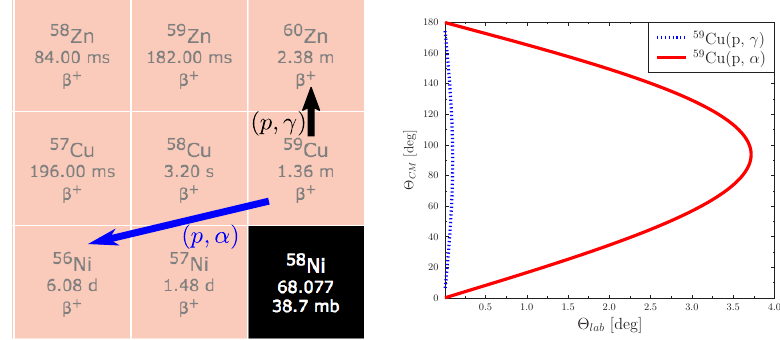
Figure 3. Left: Part of the rp process around the important 56 Ni waiting point. The 59 Cu( p ,γ ) reaction leads to 60 Zn, and, as such, successfully breaking out of the 56 Ni waiting point. The competing reaction 59 Cu( p ,α ), instead feeds back into 56 Ni. Right: Transformation of the center-of-mass scattering angle of the heavy residuals into the laboratory azimuthal angle Θ lab for the two example reactions considered here. The CM energy of both reactions is set to 4 MeV to be still measurable in the ESR (see Fig.